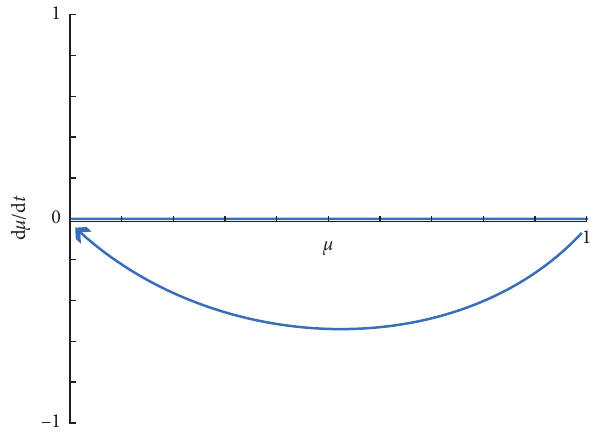
Figure 7: The evolution phase diagram when η > η ∗ .